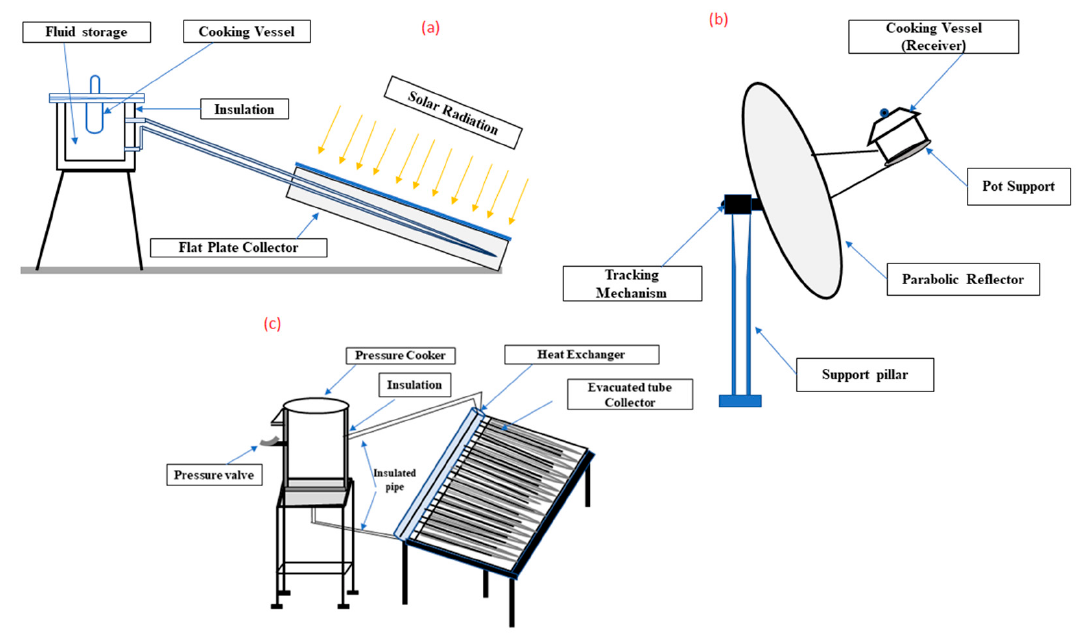
Figure 4. Indirect solar cooker types: ( a ) Flat-plate collector; ( b ) Parabolic collector; ( c ) Evacuated tube collector .